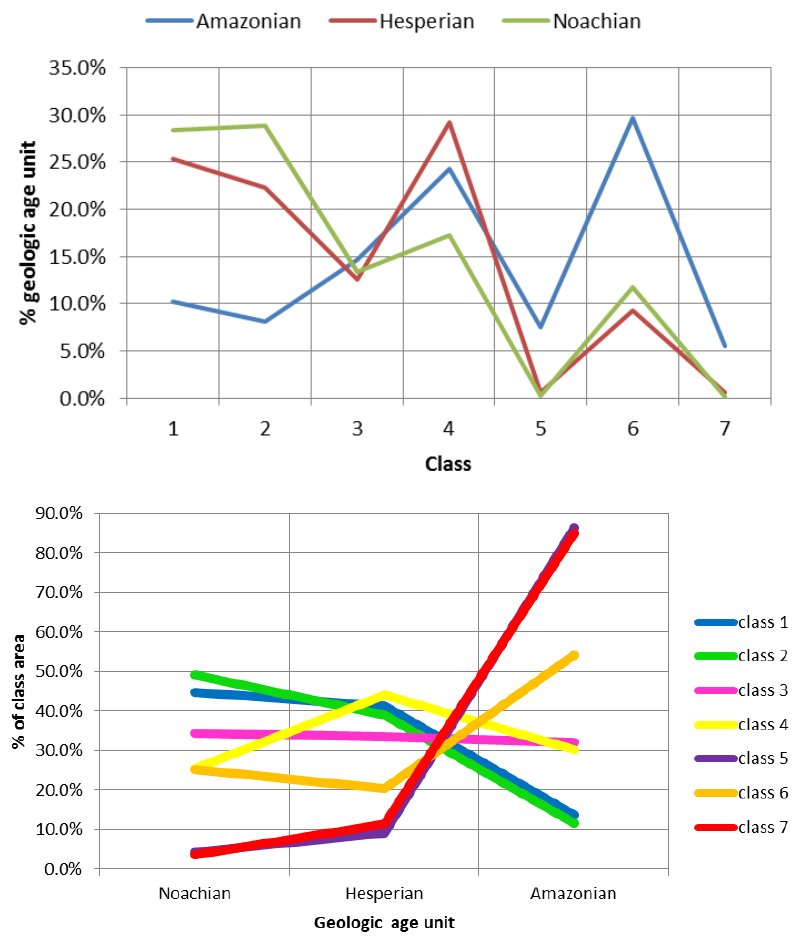
Figure 21. The relationship between terrain age [156] and the thermophysical map of Figure 13. ( Left ), percentage counts are plotted. All terrains have a broad class membership. ( Right ), some classes show a strong relationship to a particular geologic epoch. For example, class 5 and class 7 terrains are predominantly Amazonian aged. Class 2 shows the highest fraction of Noachian terrains, and classes 1 and 4 show the highest fraction of Hesperian aged